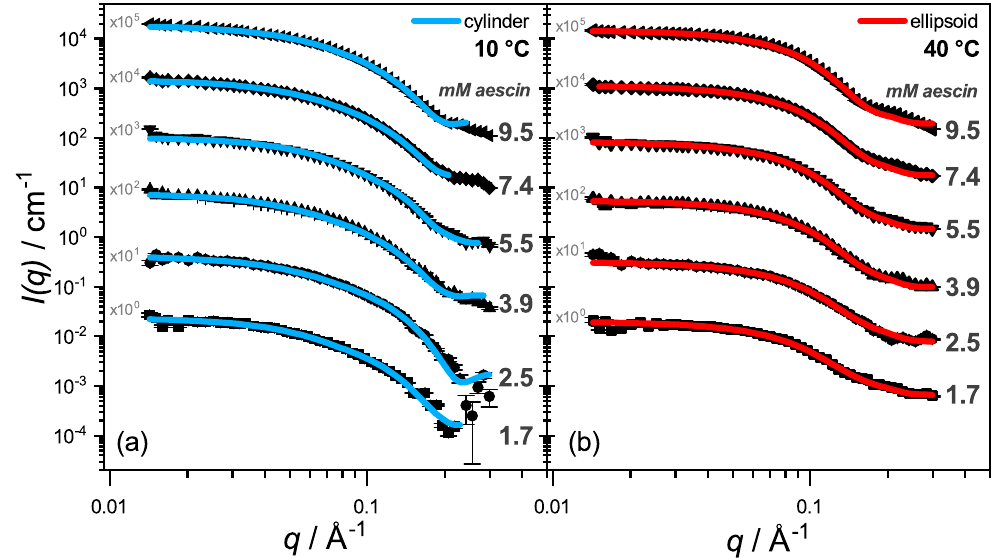
Figure 7. Model fits to the SAXS data at ( a ) 10 and ( b ) 40 ◦ C. Data at 10 ◦ C were fitted with a cylinder model and at 40 ◦ C with an ellipsoid model. Both models are implemented in SASView [58]. The data are scaled by the factors given in